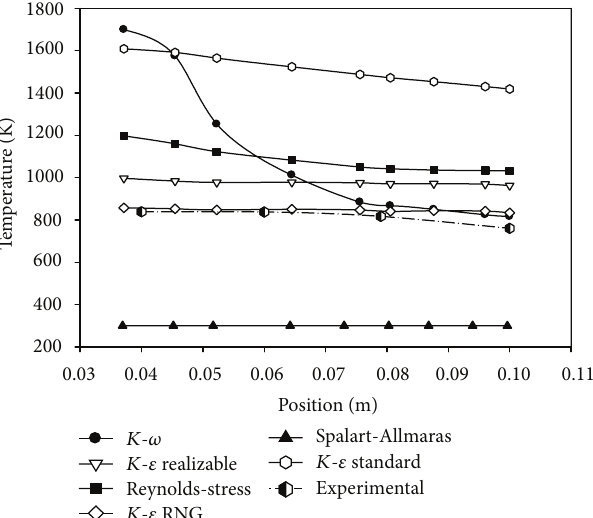
Figure 5: Comparison of the present results of central temperature profile along the chamber with the experimental result.